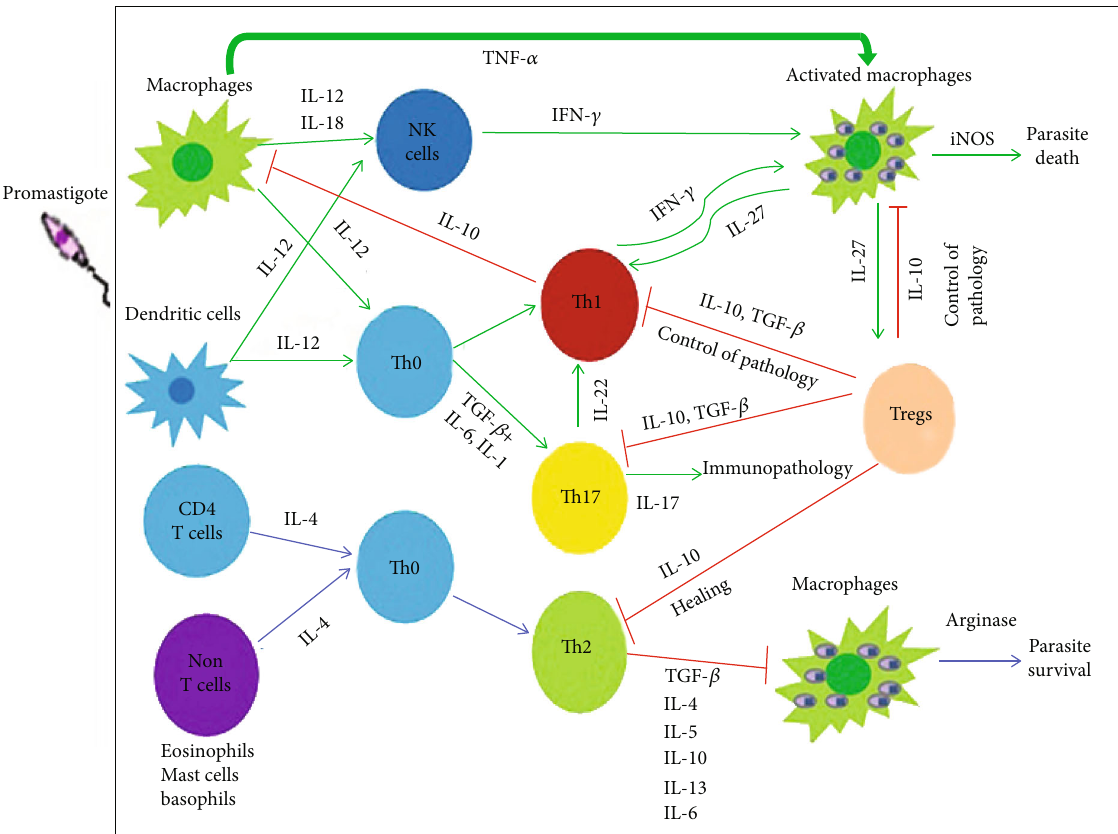
Figure 4: Cytokine pro fi le in cutaneous leishmaniasis infection (Source: Pathogens and Global Health; Maspi et